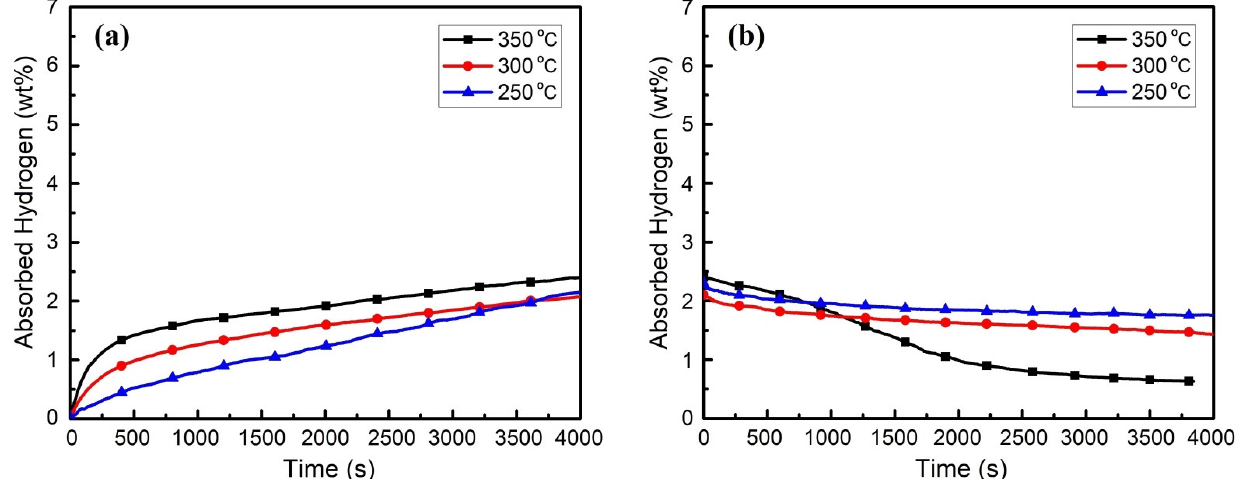
Figure 1. Kinetic of hydrogenation and dehydrogenation for as cast AZ91 alloy at different temper- atures: ( a ) Hydrogenation at pressure of 30 bar; ( b ) Dehydrogenation at pressure of 10 − 1 mbar. Hydrogenation and dehydrogenation behaviors for the S1 and S2 samples are illus-